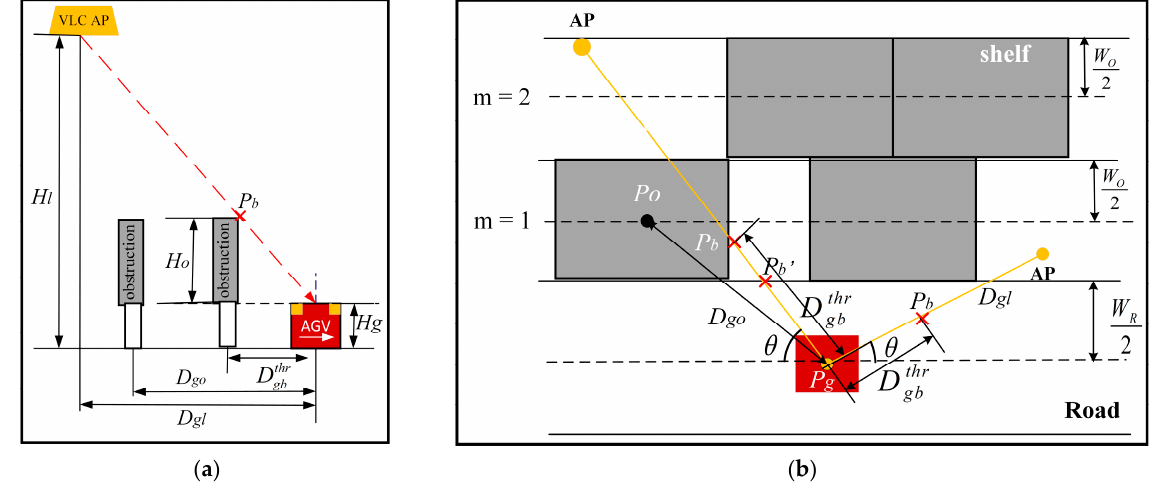
Figure 2. Analysis of link blockage caused by static obstacle: ( a ) horizontal view; ( b ) top view. If the VLC link has an intersection with the obstacle and the horizontal distance from the intersection to the AGV is less than 𝐷 (cid:3034)(cid:3029)(cid:3047)(cid:3035)(cid:3045) , the VLC link will be blocked. In this paper,